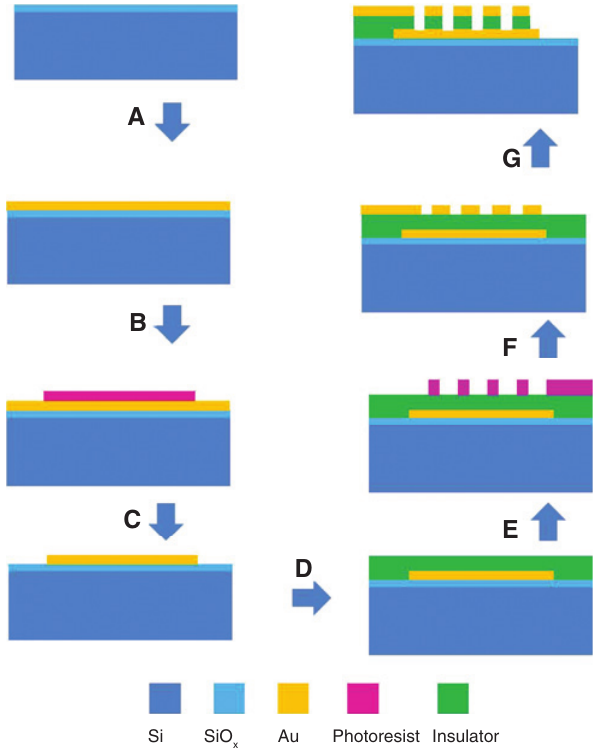
Figure 2: Illustrations of fabrication processes for non-planar double structured electrode systems. (A) Sputtering of adhesive and subsequent electrode metal layer; (B) first photolithography step and patterning of photoresist; (C) wet-etching and removal of photoresist; (D) formation of insulating layer; (E) second photolitho- graphic step and patterning of photoresist; (F) sputtering of second electrode material after deposition of adhesive layer; (G) dry-etch- ing of insulating